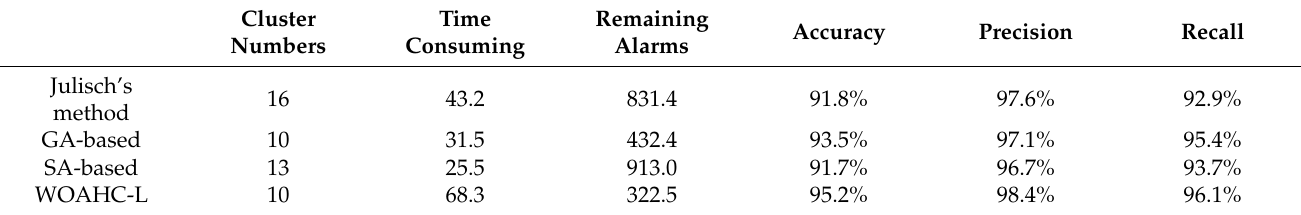
Table 6. A detailed comparison of experimental results between WOA and Julisch’s method, GA and